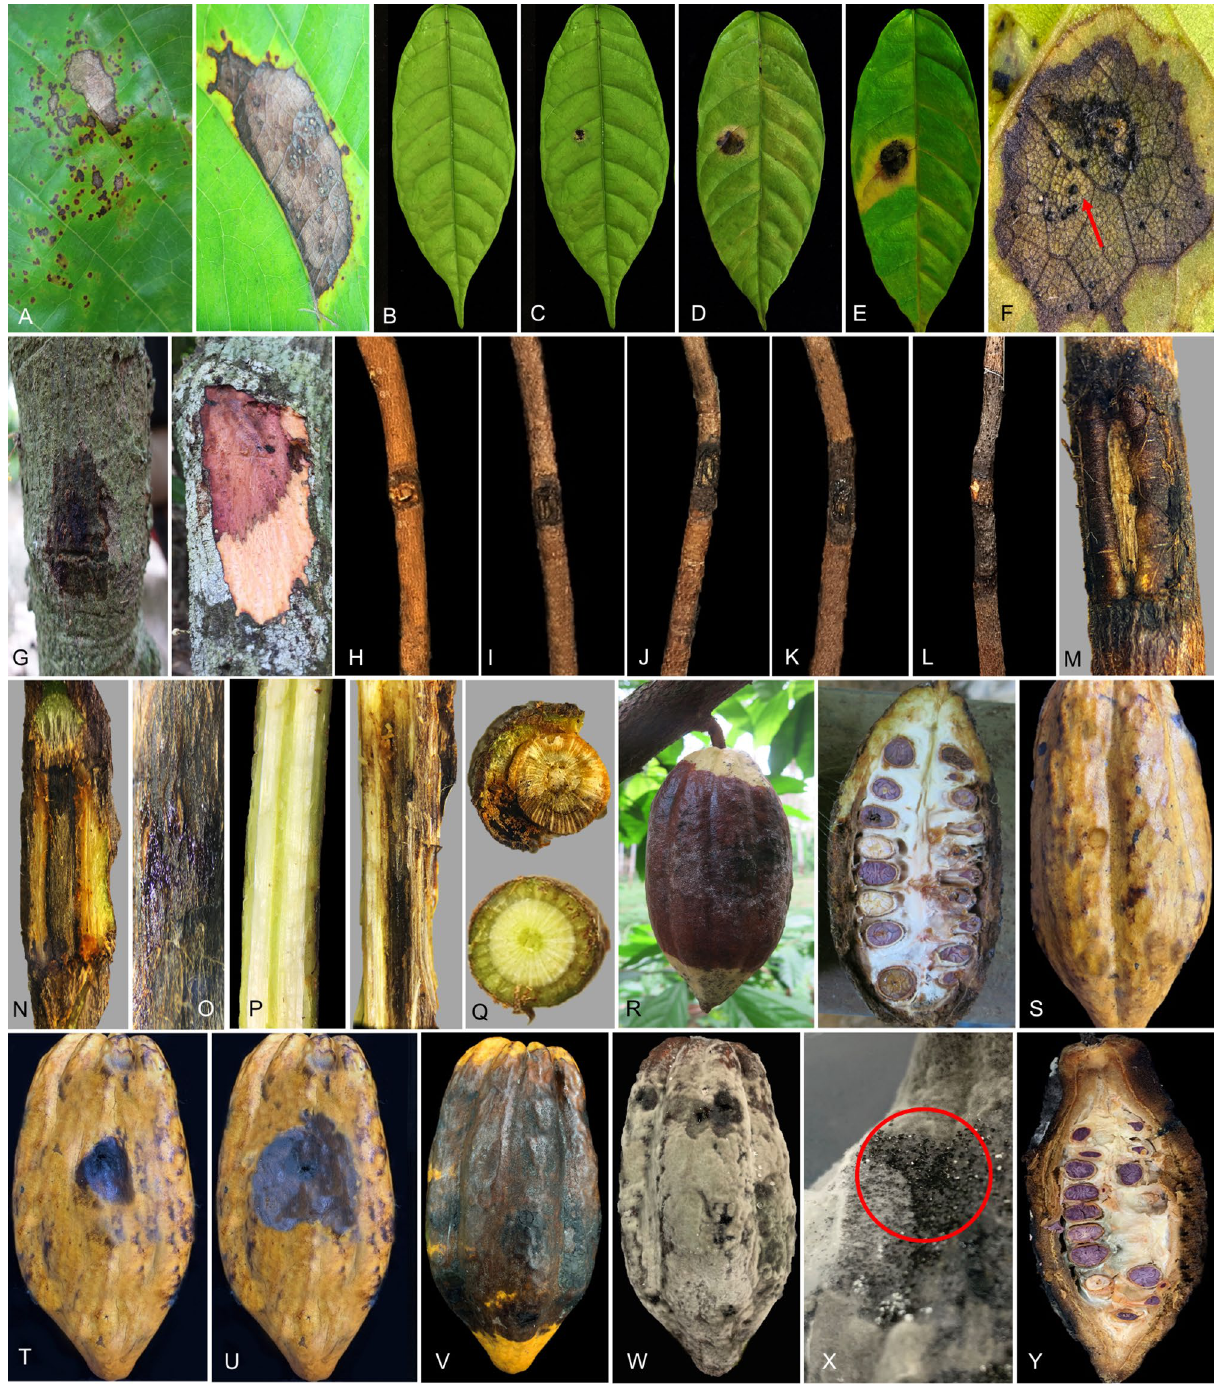
Figure 3. Pathogenicity of Lasiodiplodia theobromae on leaves, stems, and pods of Theobroma cacao . ( A ) Blighted leaf observed in the field, ( B ) Asymptomatic control inoculated leaf, ( C ) Irregular black lesions with yellow halo observed after 4 days of inoculation ( D , E ) The lesions enlarged after 6 and 9 days of inoculation, respectively, ( F ) Presence of conidiomata on the diseased area (red arrow), ( G ) Cankered stem observed in the field, ( H ) Asymptomatic control inoculated stem, ( I–K ) Black necrotic lesions observed on the inoculation sites after 7, 14, and 21 days of inoculation, respectively, ( L ) Black necrotic lesions extending upwards and downwards after 28 days of inoculation, ( M ) Black sunken lesion on the inoculation site, ( N ) Incision of the stem inoculated site showed reddish-brown to black necrotic lesion, ( O ) Formation of gummosis on the necrotic lesion, ( P ) Vertical section of control (left) and fungal inoculated stems (right) showed symptomless and dark brown to black necrotic lesion, respectively, ( Q ) Transverse section of control (below) and fungal inoculated stems (above) showed symptomless and necrotic lesion, respectively, ( R ) Rotted pod observed in the field showed external and internal rotting symptoms, ( S ) Asymptomatic control inoculated pod, ( T ) Brown to black lesions observed on the inoculation sites after 5 days of inoculation, ( U ) The lesions enlarged after 7 days of inoculation ( V ), The lesion rapidly expanded after 9 days of inoculation, ( W ) The inoculated pod completely covered by the fungal mycelia after 12 days of inoculation, ( X ) Presence of black conidiomata (red circle) on the fungal inoculated pod, ( Y ) Cross-section of fungal inoculated pod showed rotting of the internal